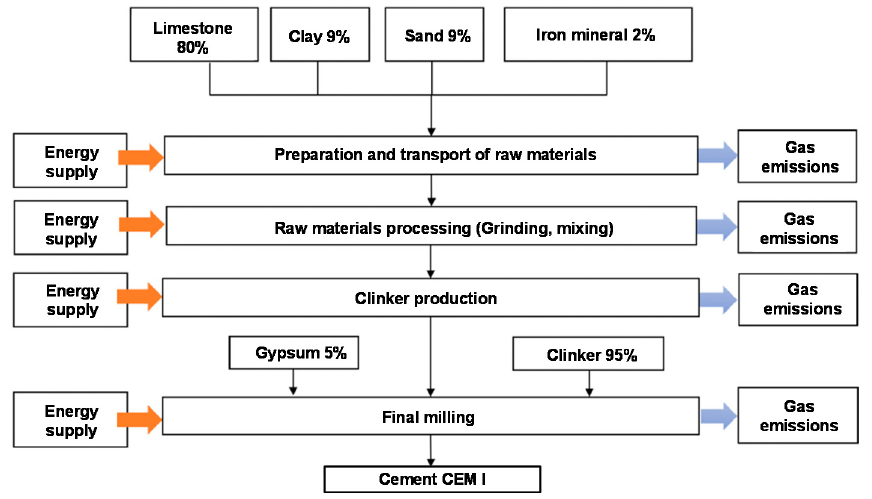
Figure 1. Basic process, “cradle-to-gate” scope and system limits [27].